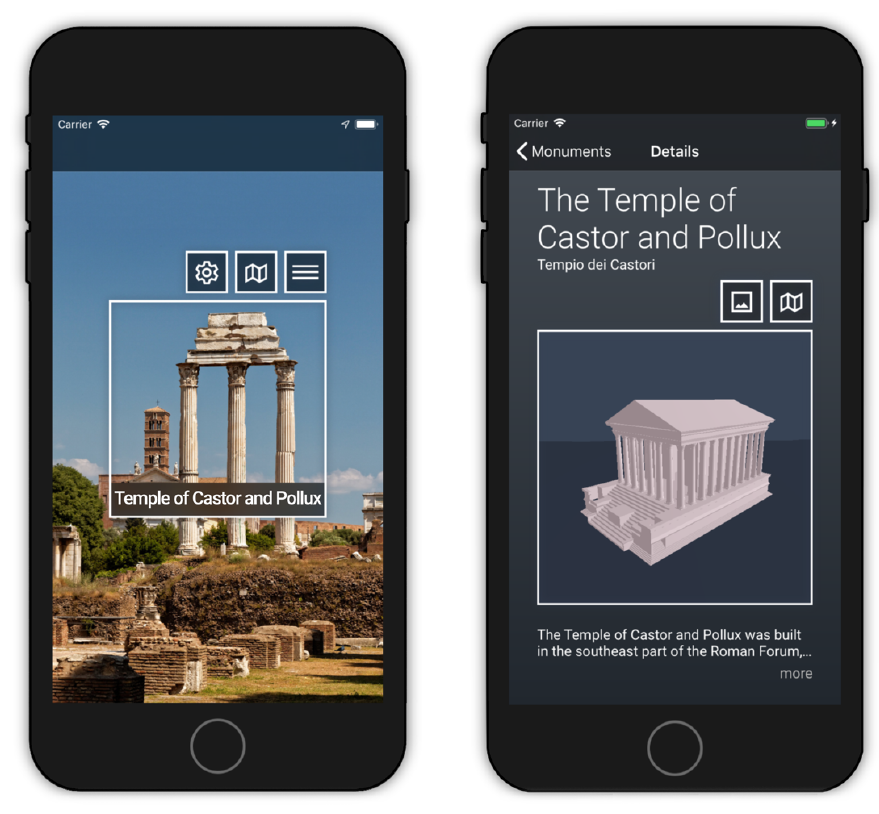
Figure 4. Screenshots of the App. The main page shows the camera monitor, a square to frame monuments and the prediction label. The monument page hosts a description, the interactive 3D reconstruction and buttons to show images and